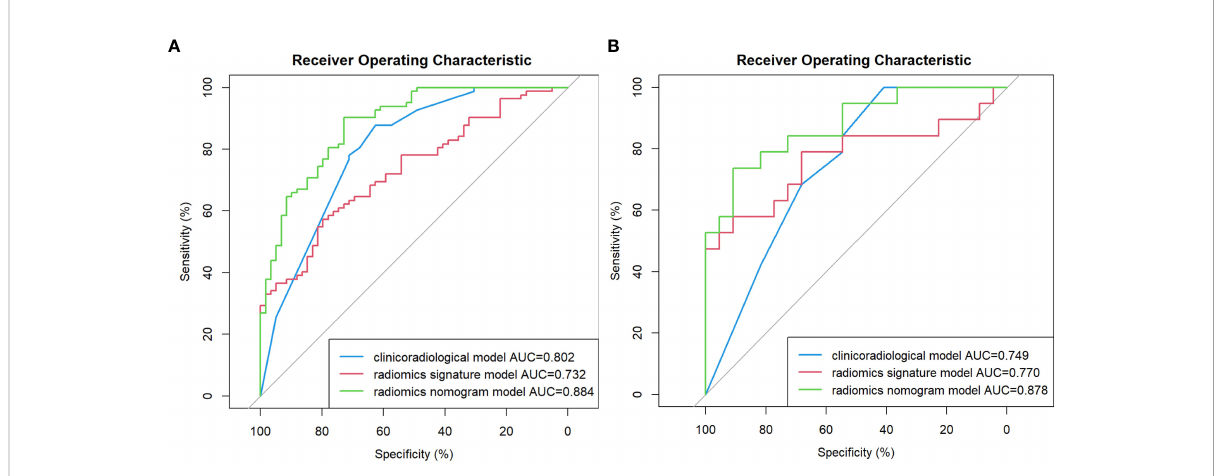
FIGURE 2 Comparison of receiver operating characteristic (ROC) curves for the prediction of microvascular invasion. ROC curves of the clinicoradiological model, the radiomics signature model and the radiomics nomogram model in the training and validation cohort (A, B) ,